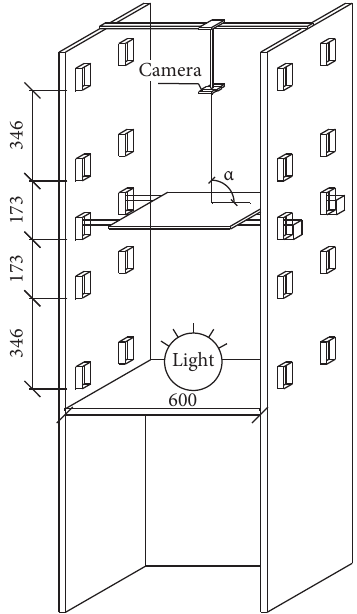
Figure 2: 2D contour feature photography assistant